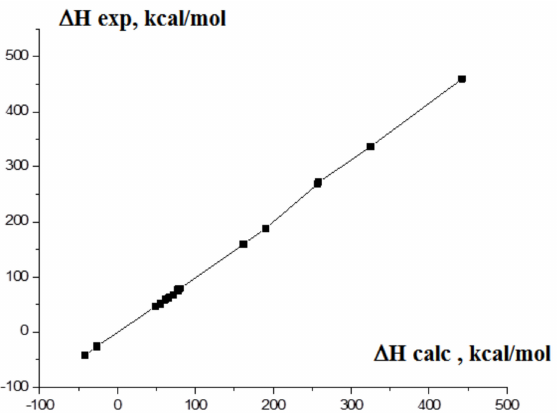
Figure 11. The interdependence of the calculated and experimental EOF values of tested compounds. Using the values of parameters [32] for the crystalline carbon and boron, the EOF magnitudes of compounds 9 – 11 and 15 – 17 were calculated (see Table